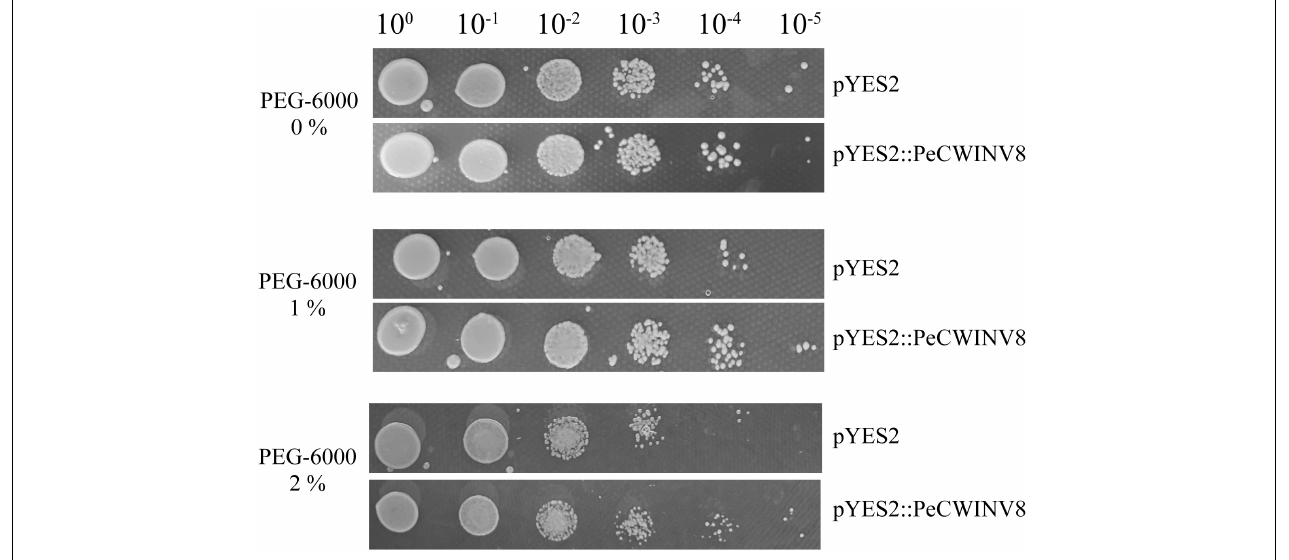
FIGURE 9 | Effect of PeCWNV8 expression on yeast under drought stress. Yeast cells with pYES2 vector only (pYES2) and yeast cells harboring PeCWINV8 expressing construct (pYES2:PeCWINV8) were subjected to 1 or 2% PEG-6000. Cell density adjusted to OD 600 at 1.0 and serial dilutions were made at each step. Five microliters of each dilution were inoculated on SC-U medium, SC-U medium supplemented with PEG-6000. Photographs were taken after 2 days of incubation at 30 ◦